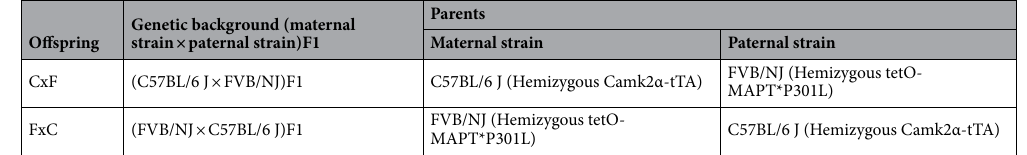
Table 1. The genetic backgrounds of the two mouse strains obtained by reciprocal